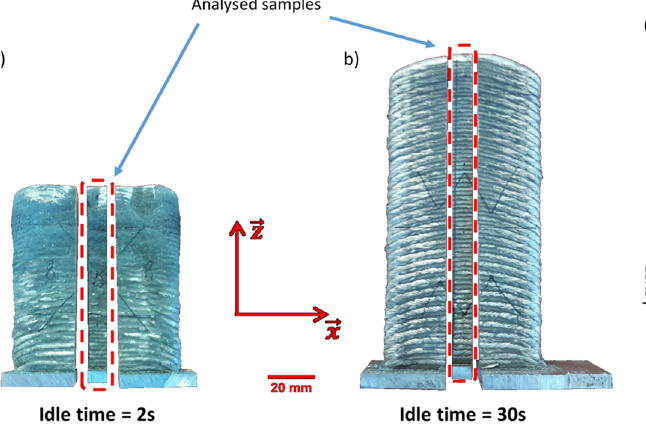
Fig. 8. Manufactured parts and sample de fi nition: (a) idle time =2s, (b) idle time= 30s.